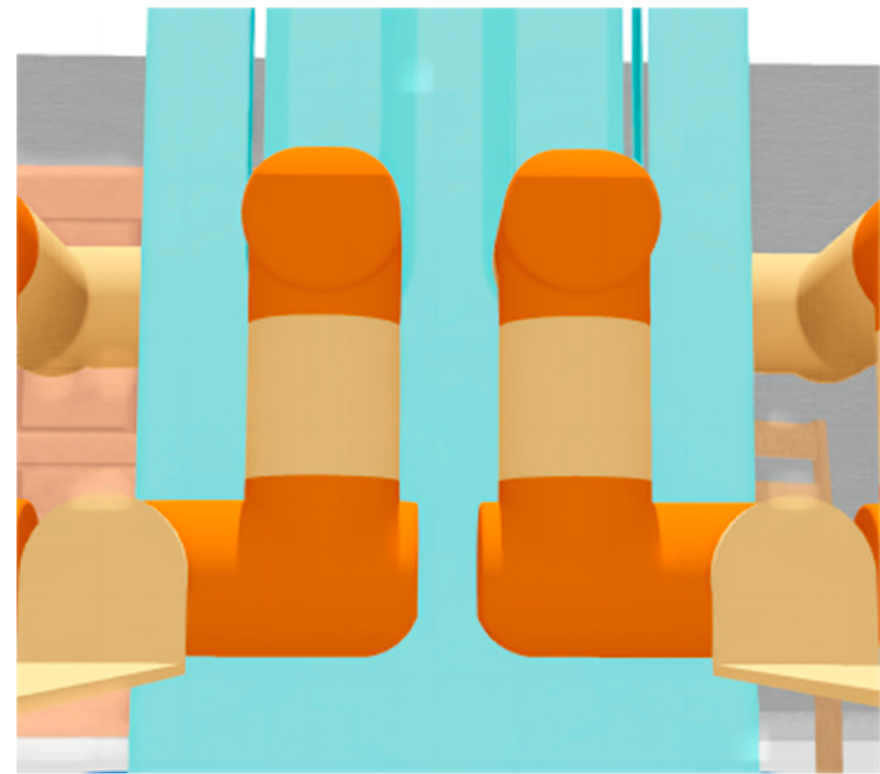
Figure 8. Dual-manipulator LF-RF without risk of self-collision.